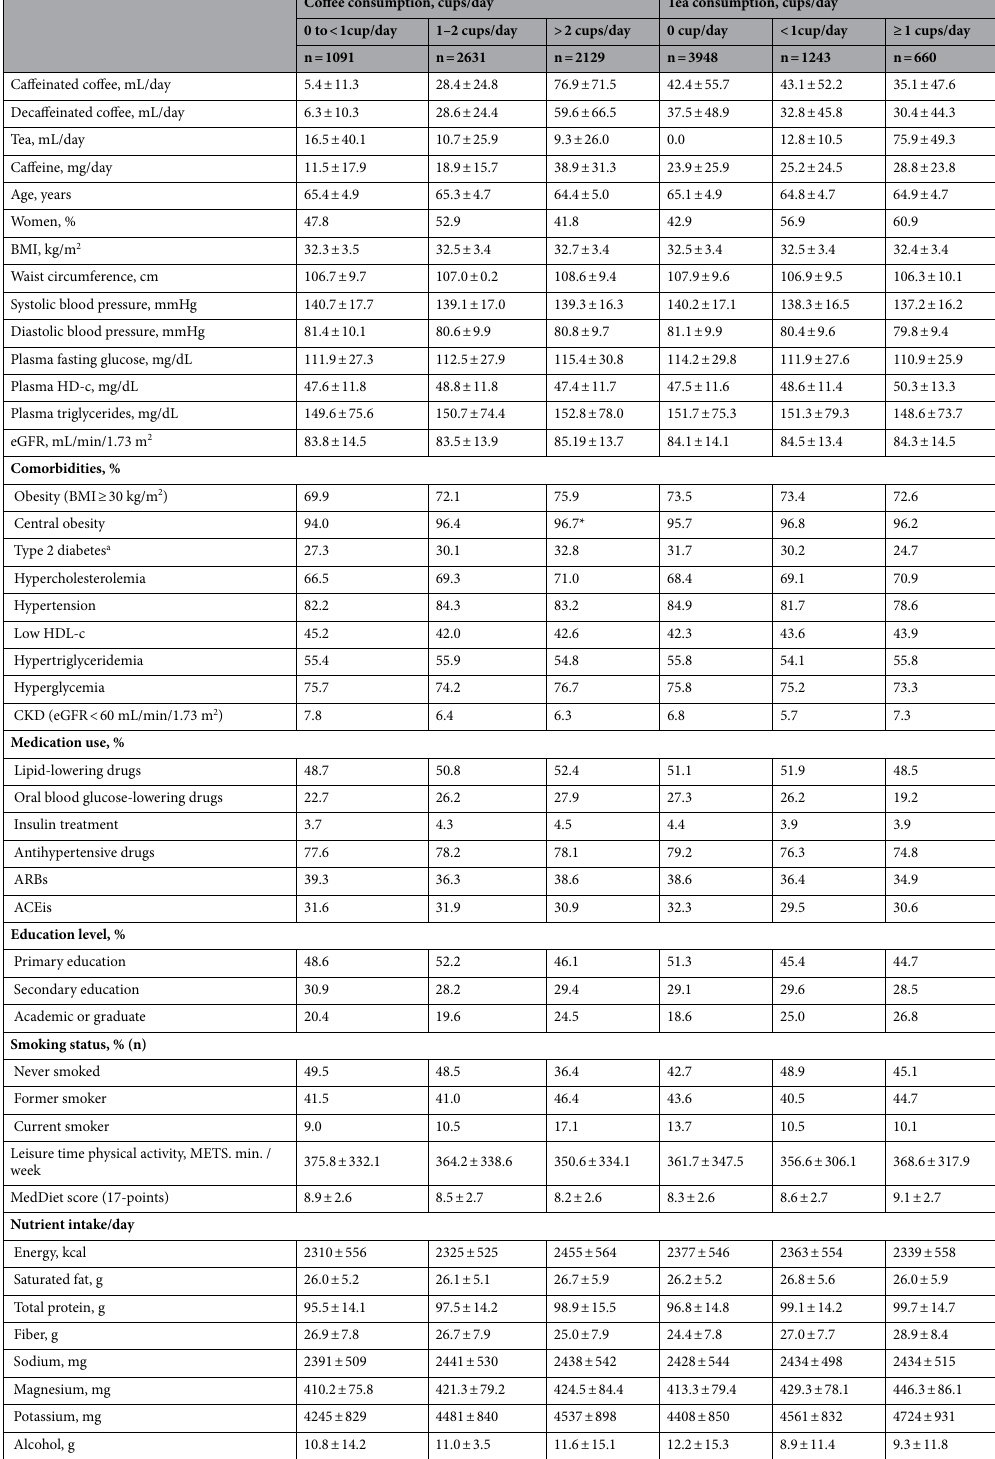
Table 1. General characteristics of the studied population according to categories of total coffee and tea consumption. Values are means (± SD) and percentages for continuous and categorical variables, respectively. BMI body mass index, SBP systolic blood pressure, DBP diastolic blood pressure, HDL-c high-density lipoprotein-cholesterol, ARBs angiotensin-type 2 receptor blockers, ACEis angiotensin converting enzyme inhibitors, eGFR estimated glomerular filtration rate, MedDiet Mediterranean diet. a Current diabetes was defined as previous diagnosis of diabetes, glycated haemoglobin (HbA1c) ≥ 6.5%, use of antidiabetic medication, or having fasting glucose > 126 mg/dL in both the screening visit and baseline visit. b P value